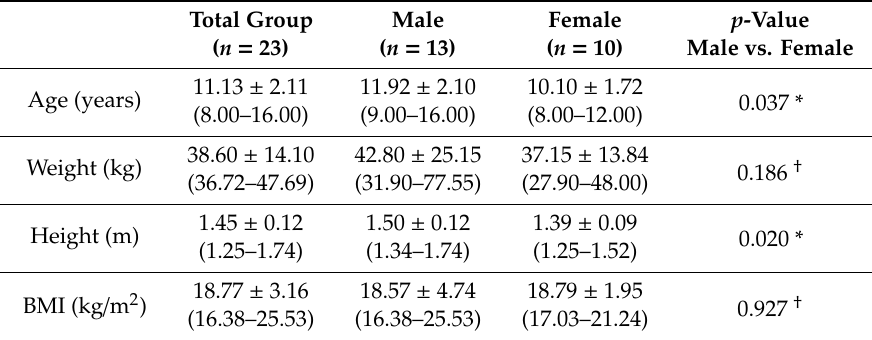
Table 1. Socio-demographic characteristics of the sample population.